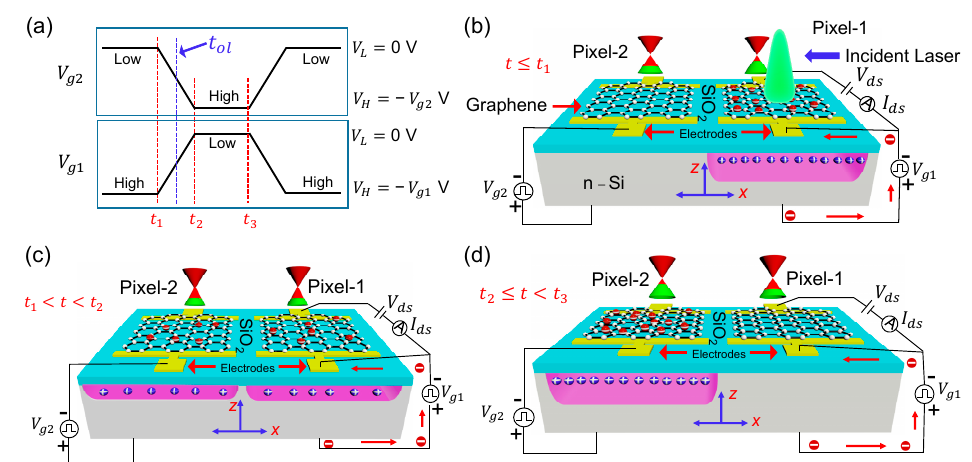
Figure 3. ( a ) The temporal dynamics of V g 1 and V g 2 phasing gate voltages are shown, indicating the crucial moments in the back-and-forth charge transfer experiment. ( b – d ) The schematics and related electrical circuitry required for the two adjacent Gr-Si CCD pixels for three conditions t ≤ t 1 ( V g 1 is high), t 1 < t < t 2 (switching of V g 1 and V g 2 ), and t 2 < t < t 3 ( V g 2 is high) are shown. In-situ sensing of the back-and-forth charge transfer between neighboring pixels can be traced by the channel current I ds . The charge density in the potential well affects the Femi level position in graphene. V g 1 and V g 2 induce potential wells in the adjacent pixels. The fringing electric field produced at the Si/SiO 2 interface in the inter-pixel region drives the charge transfer.